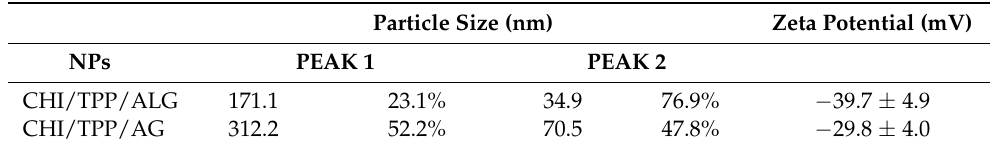
Figure 4. Micrographs of the ( A ) CHI/TPP/ALG and ( B ) CHI/TPP/AG NPs. The results for particle size and zeta potential were evaluated as a function of the total volume fraction of NPs loaded with cardanol, shown in Table 1. Table 1. Particle size and zeta potential evaluated as a function of the total volume fraction of NPs CHI/TPP/ALG and CHI/TPP/AG loaded with